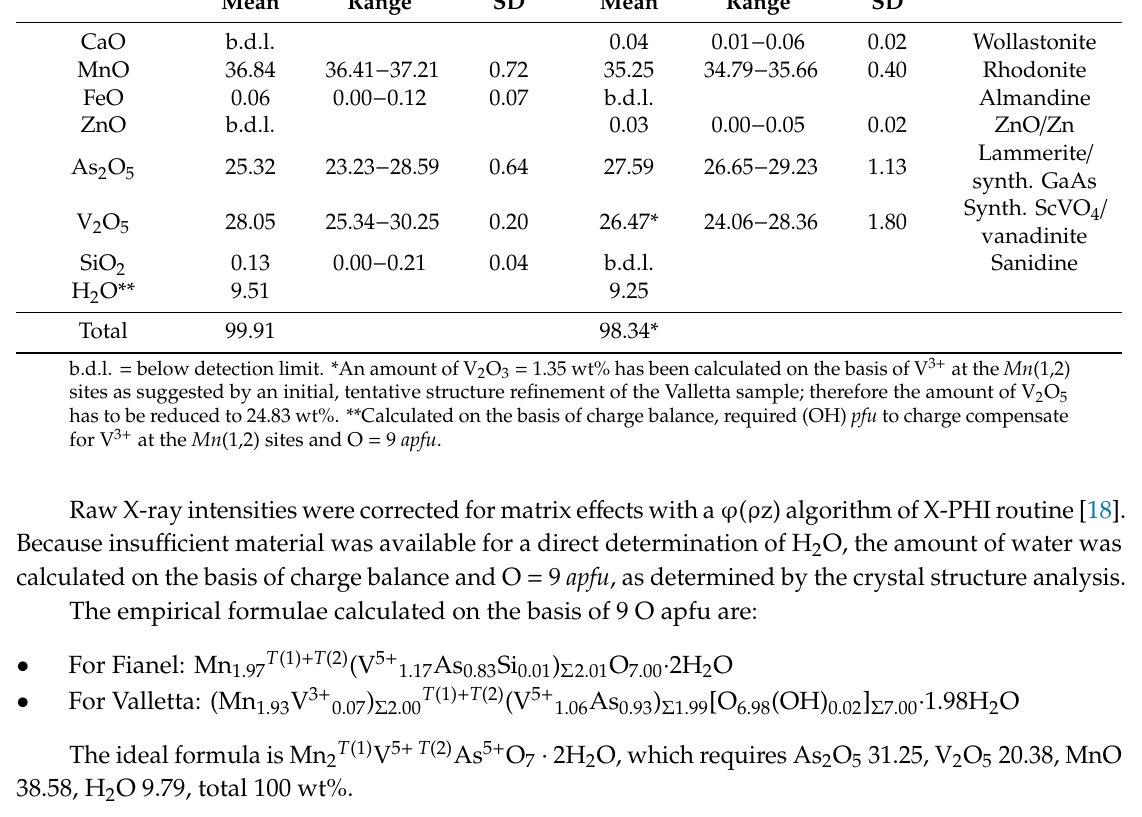
Table 1. Chemical composition (wt%) of rüdlingerite from Fianel and Valletta Mines. Fianel Specimen (16 Point Constituent